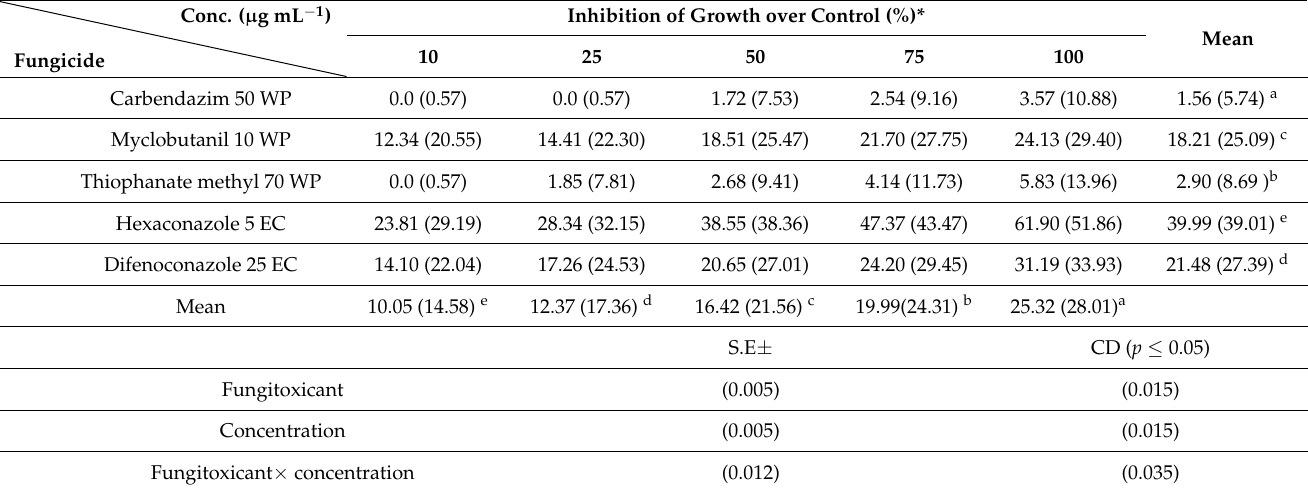
Figure 8. Comparative bar chart (left) designates the effect of systemic fungitoxicants under in vitro conditions against T. harzianum mycelium, where Carben = Carbendazim 50 WP, Myclo = Myclobu- tanil 10 WP, Thiopha = Thiophanate methyl 70 WP, Hexacona = Hexaconazole 5 EC, Difenoc = Difeno- conazole 25 EC, Sys INHP = mycelial inhibition of Pathogen. Table 8. Effect of systemic fungitoxicants on host A. bisporus mycelium under in vitro